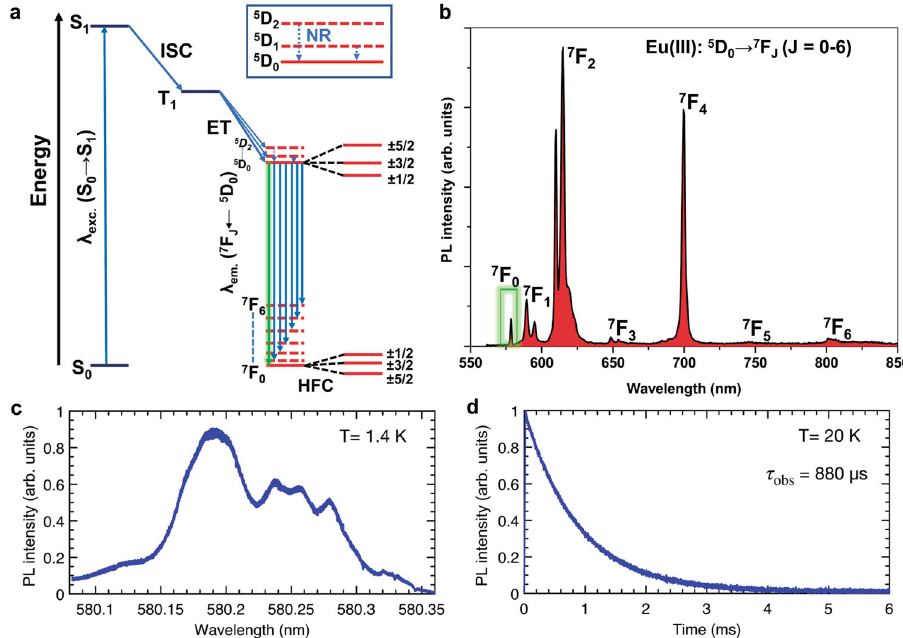
Fig. 2 Photophysical properties of [Eu 2 ] in the solid-state. a Mechanism of PL sensitization in Eu(III) complexes: the Eu(III)-based 5 D J ( J = 0 – 2) receiving levels are populated after a series of excitation, intersystem crossing (ISC), and T 1 → 5 D J energy transfer (ET) processes. The co-populated excited 5 D 2 and 5 D 5 D 5 D 7 F J ( J = 0 – 6) crystal fi eld levels manifests as line-like 1 levels non-radiatively (NR) relax to 0 level (inset); radiative relaxation of 0 level to ground luminescence. The 5 D 0 → 7 F 0 transition is suited for QIP applications due to its narrow linewidth and long coherence lifetimes of the nuclear spin states — ±5/2, ±3/2, ±1/2 (I = 5/2 for 151 Eu/ 153 Eu) — associated with the 7 F 0 ground-state level. b Photoluminescence spectrum showing the 5 D 0 → 7 F J ( J = 0 – 6) transitions in the visible and near-IR range ( λ exc. = 330 nm). c Photoluminescence excitation (PLE) spectrum of the 5 D 0 → 7 F 0 transition of [Eu 2 ] measured at 1.4 K. An inhomogeneous linewidth ( Γ inh ) of 50 GHz is calculated for the main peak centered at 580.185 nm (vac.) d Luminescence decay of the 5 D 0 excited-state of [Eu 2 ] measured at 20 K under resonant excitation at 580.185 nm. An excited-state lifetime ( τ obs ) of 880 μ s was obtained from a single exponential fi t of the